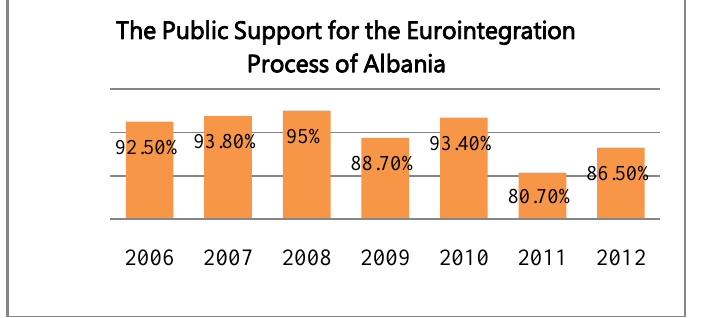
Figure 1: The Public Support for the Eurointegration Process of Albania (2003-2012) (Source: AIIS: Perceptions and Realities 2012,